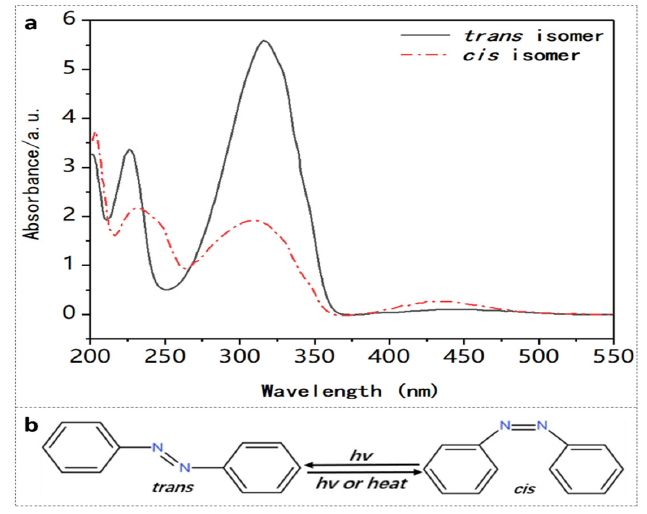
Figure 7. ( a ) UV-vis spectra of AZO before ( trans isomer) and after ( cis isomer) UV irradiation. Adapted with permission from [58]. ( b ) Schematic of AZO photoisomerization [57].